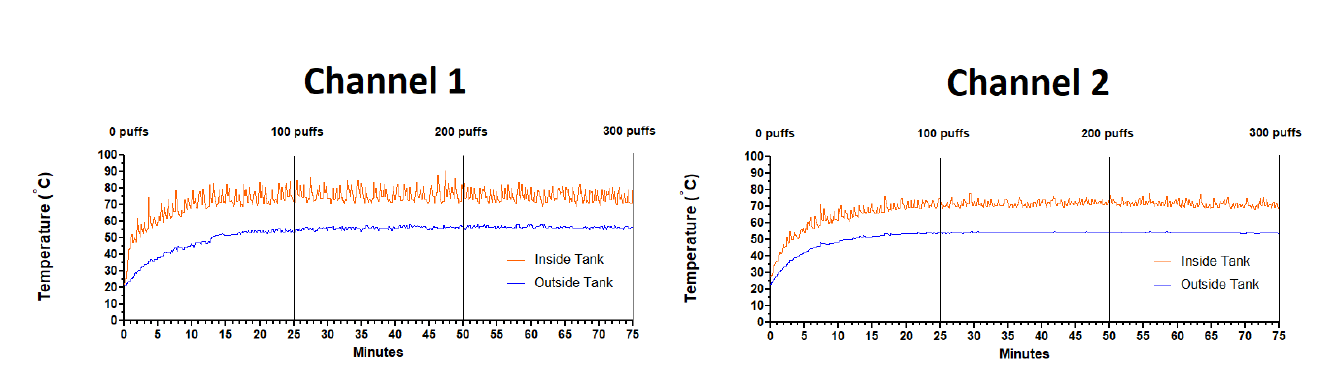
Table 2. Statistics of Magnetic and Electrical Coil Properties after the First Five Puffs.